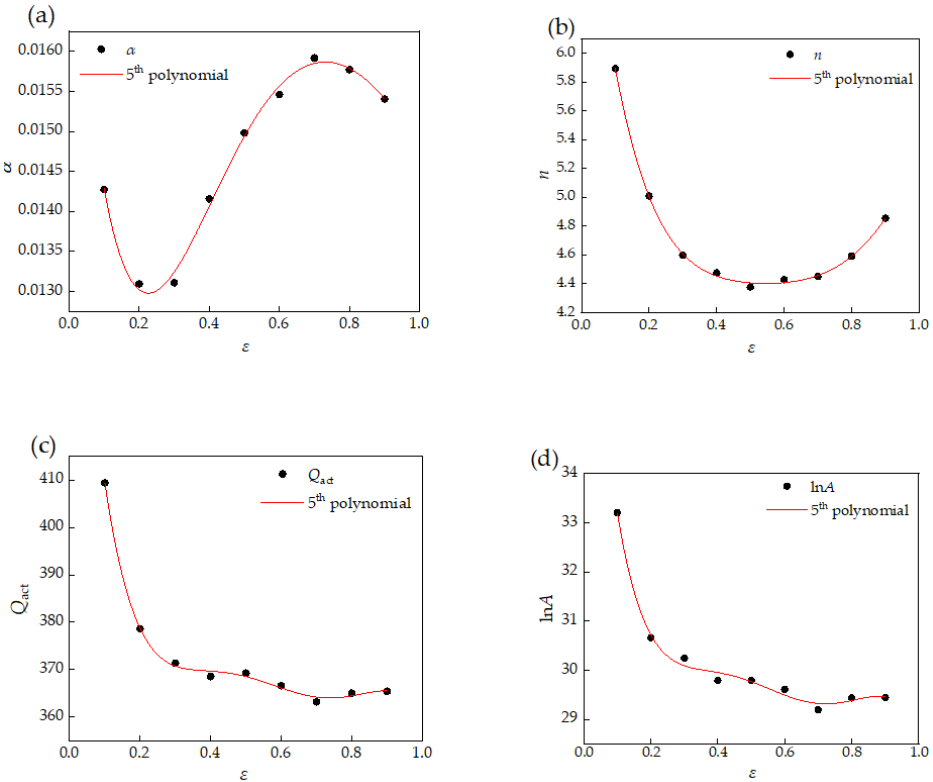
Figure 8. Constitutive constants at different strains. ( a ) α ; ( b ) n ; ( c ) Q ; ( d ) ln A .